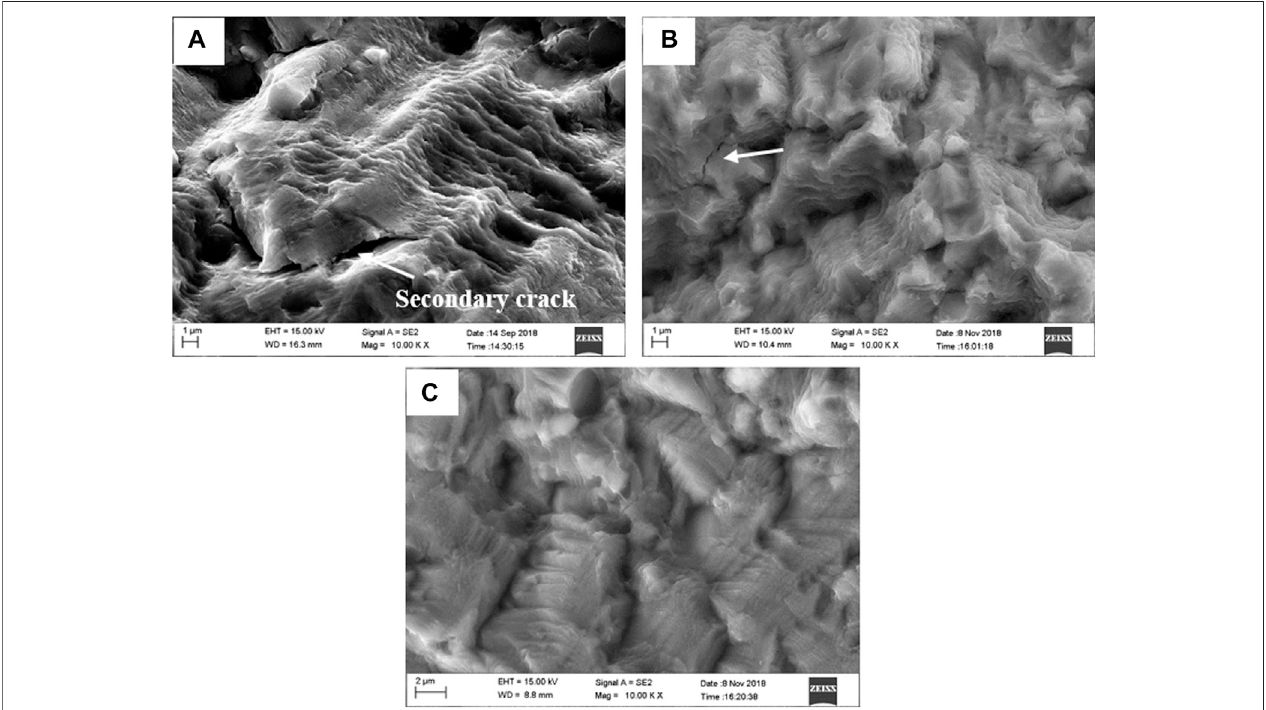
FIGURE 8 | Fatigue crack propagation zone of the alloy in different conditions and stress amplitudes, (A) T1-160 MPa, (B) T4-180 MPa, (C) T6-180 MPa.